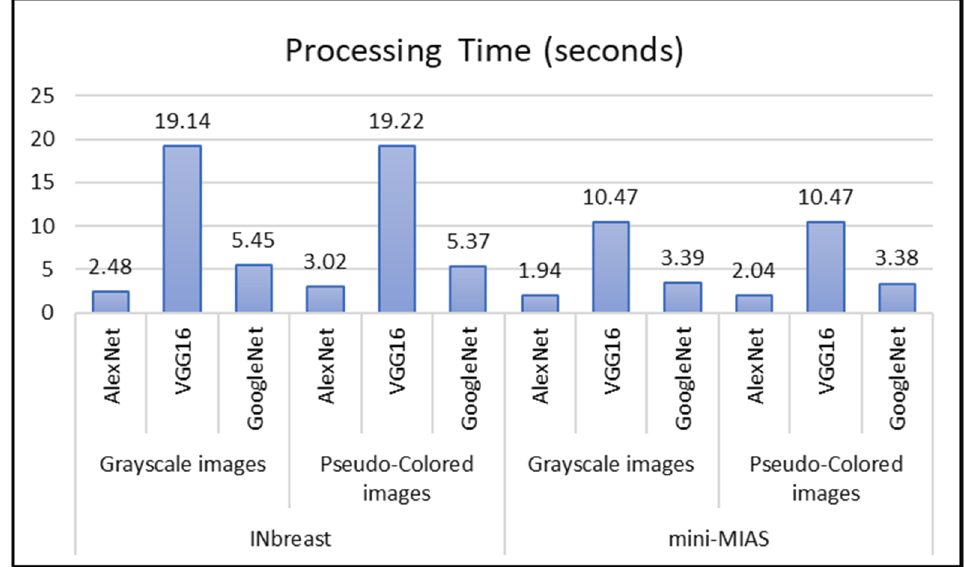
Figure 4. The retrieved processing time using Pretrained CNN for each dataset.